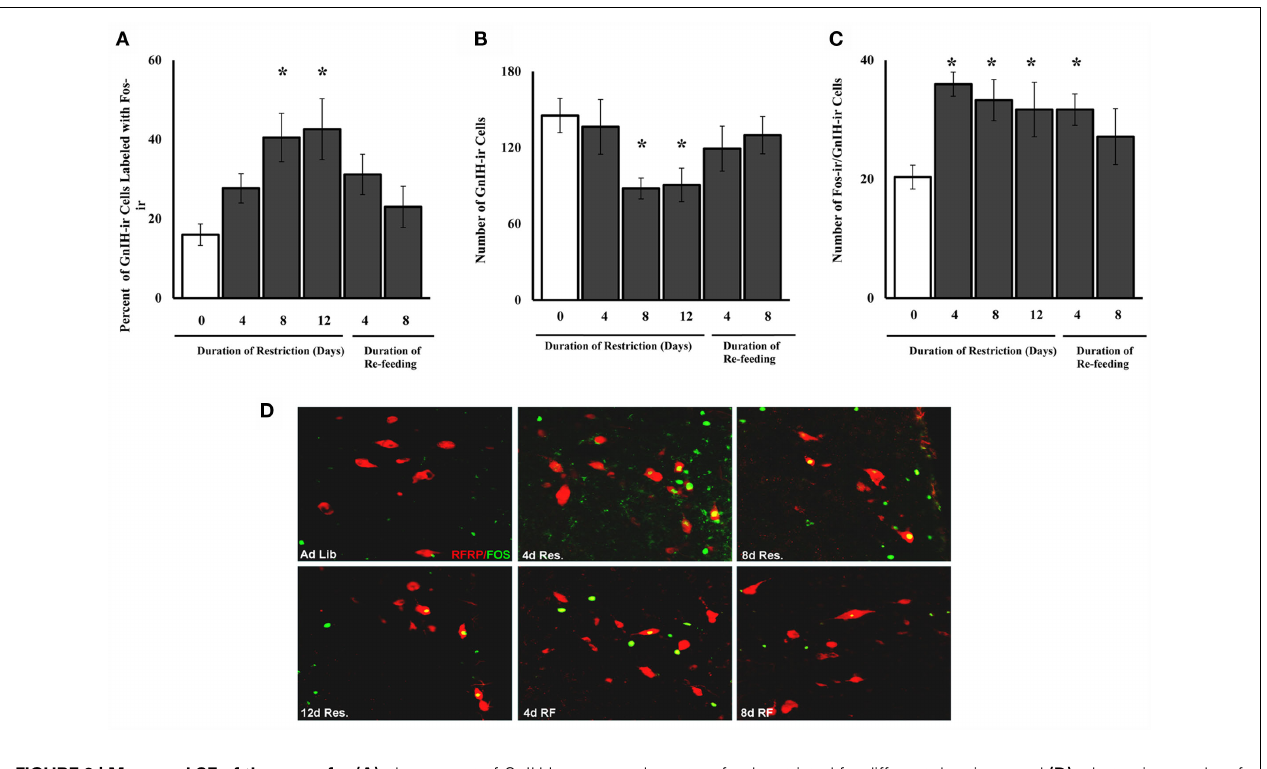
FIGURE 3 | Mean and SE of the mean for (A) . the percent of GnIH-Ir cells that showed Fos-Ir [(the number of double-labeled Fos-Ir and GnIH-Ir cells divided by the total number of GnIH-Ir cells) multiplied by 100], (B) . the number of GnIH-Ir cells per animal (both Fos-Ir-labeled and unlabeled), (C) . the absolute number of cells that were double-labeled for both Fos-Ir and GnIH-Ir in gonadally intact, female Syrian